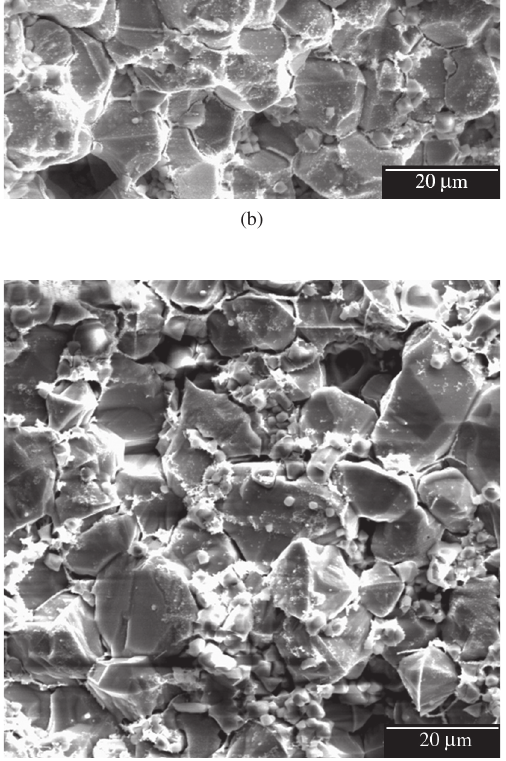
Figure 2. SEM micrographs of the fractured surface of the ZPNC samples sin- tered at 1325 °C: a) ZPNC-1; b) ZPNC-2; and c) ZPNC-3 (bar = 20